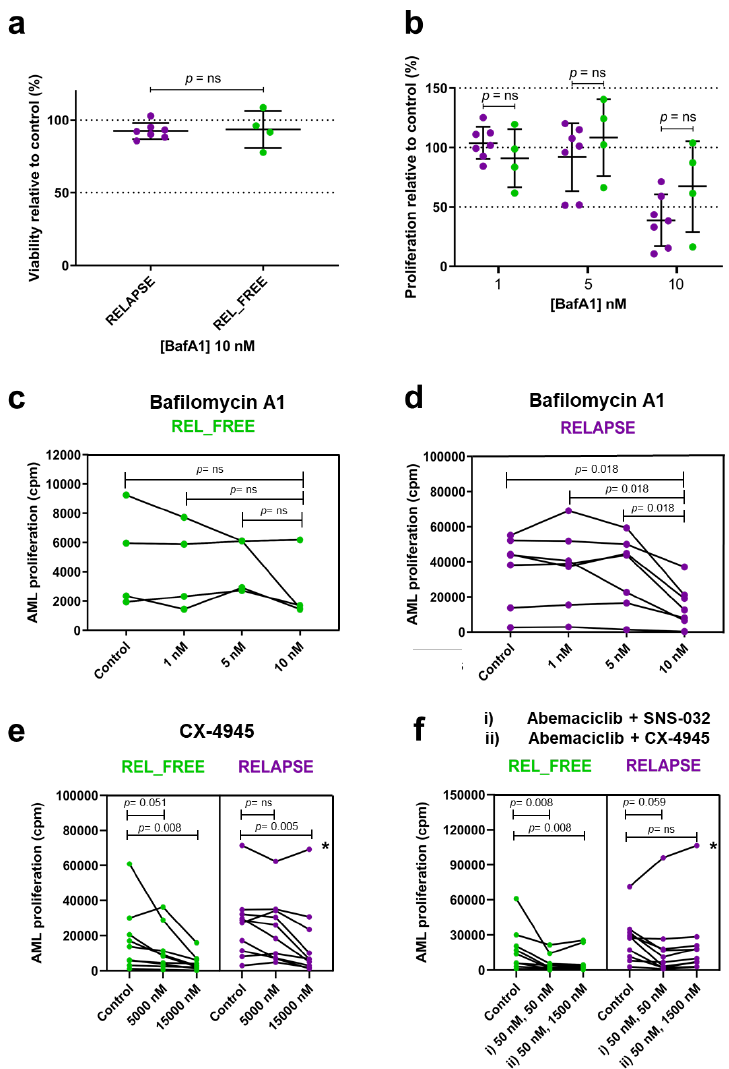
Figure 4. The effect of inhibitors of V-ATPases, casein kinase 2 (CSK2) or cyclin-dependent kinases (CDKs) on AML cell proliferation. AML patient cells were treated for six days with the indicated inhibitors. The thymidine incorporation-based proliferation measurements are presented as dots (purple for RELAPSE and green for REL_FREE) in patient groups or in individual patient curves. Significance of inhibitor treatment between patient groups and of inhibitor treatment vs. untreated control was found using the Mann–Whitney U test and the Wilcoxon matched-pair signed rank test, respectively. Non-significant results are indicated with “ p = ns”. ( a ) Viability of cells relative to untreated control for RELAPSE and REL_FREE groups, when treated with 10 nM of V-ATPase inhibitor Bafilomycin A1 (BafA1). ( b ) Di ff erences of cell proliferation relative to control for RELAPSE and REL_FREE groups when treated at 1, 5 and 10 nM BafA1. ( c , d ) Cells from four REL_FREE and seven RELAPSE patients treated with BafA1. The RELAPSE, but not the REL-FREE, patients had decreased proliferation (measured after 6–7 days of culture) when treated with 10 nM BafA1 inhibitor compared to control, 1 and 5 nM. Non-significant change was observed between control and 1 nM or 5 nM BafA1 inhibitor for either groups. ( e , f ) Cells from nine REL_FREE and ten RELAPSE patients (five and four of them were external to the patient cohort, respectively) were treated with CSK2, CDK2 / 7 / 9 and CDK4 / 6 kinase inhibitors in cell proliferation assays, alone or in combination. The CSK2 inhibitor CX-4945 was given at 0 (i.e., control), 5000 and 15000 nM alone. The CDK4 / 6 inhibitor Abemaciclib (50 nM) was given in combination with i) the CDK2 / 7 / 9 inhibitor SNS-032 (50 nM) and ii) CX-4945 (1500 nM). The same RELAPSE patient with high cell proliferation is represented with an asterisk